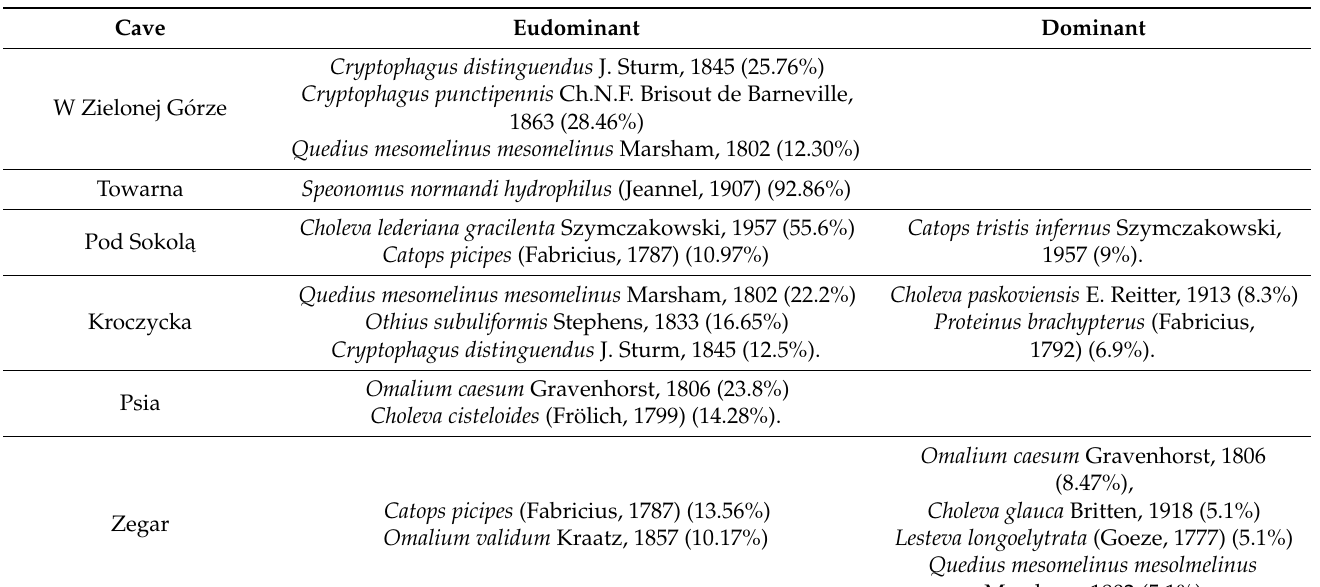
Table 3. Dominant species in the studied